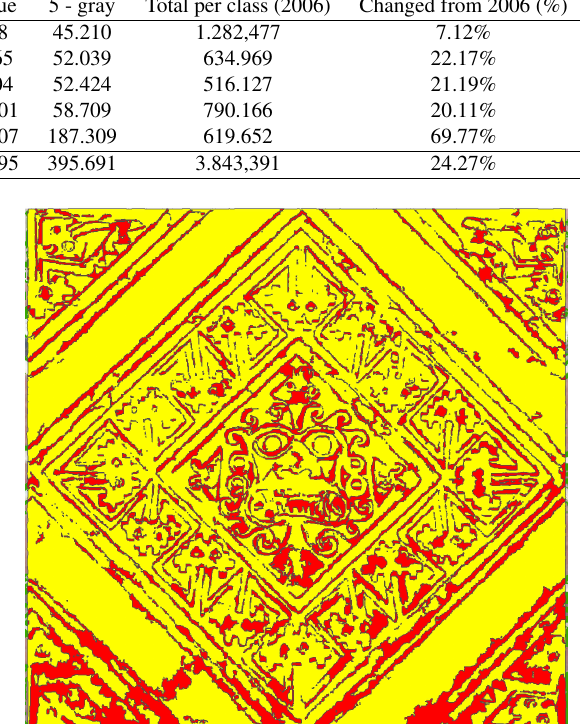
Figure 7. Stability map based on WTA classification: yellow polygons are stable while red ones are